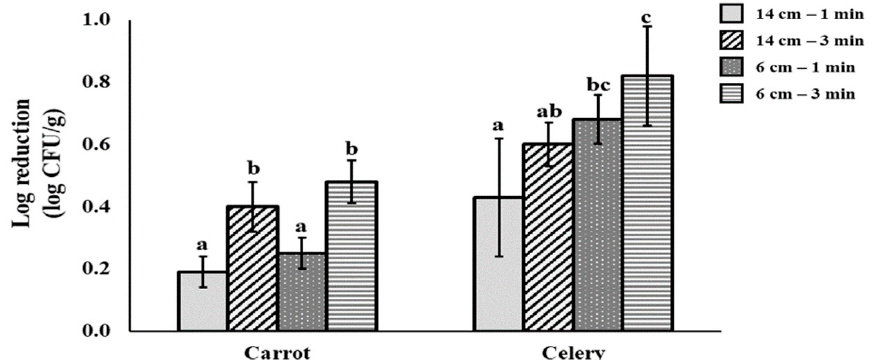
Figure 1. Reduction effect of UV-C LED irradiation (275 nm) for pathogenic E. coli (cocktail of EPEC, ETEC, and E. coli O157:H7) in fresh-cut carrot and celery at the various conditions. Distances of 6 and 14 cm, distance between the lights and samples; 1 and 3 min, irradiation time. The data were obtained from a non-selective media. a–c Values represent significant difference by Duncan’s multiple range test at p < 0.05.